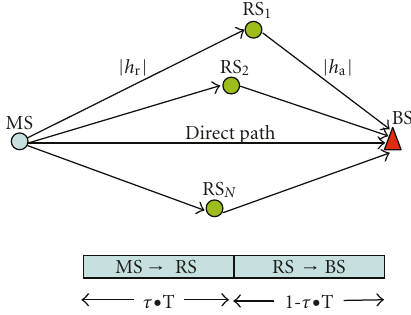
Figure 1: Illustration of a two-hop UL